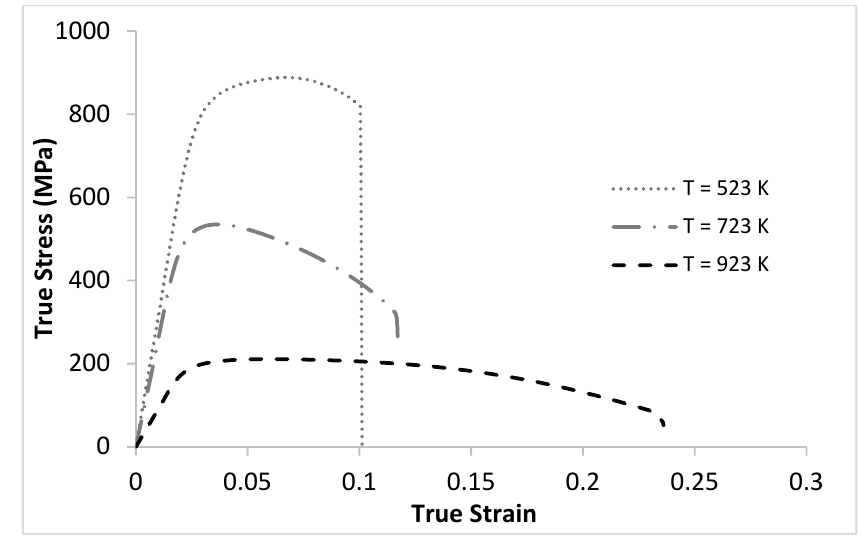
Figure 3. True stress-strain curves at high temperatures at a strain rate of 0.0015 s − 1 .